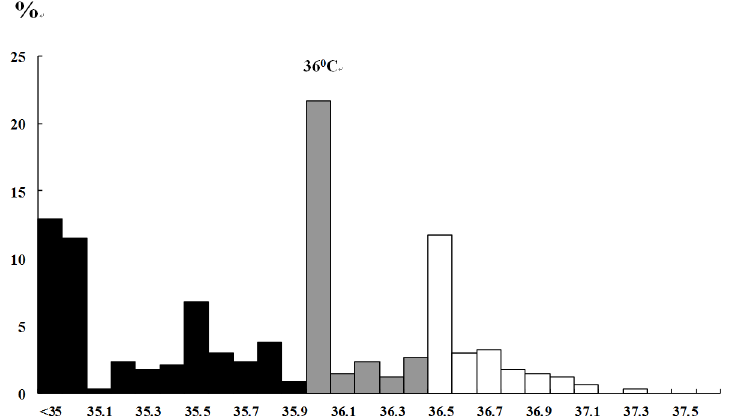
Fig 1. Temperature at admission to NICU (degrees